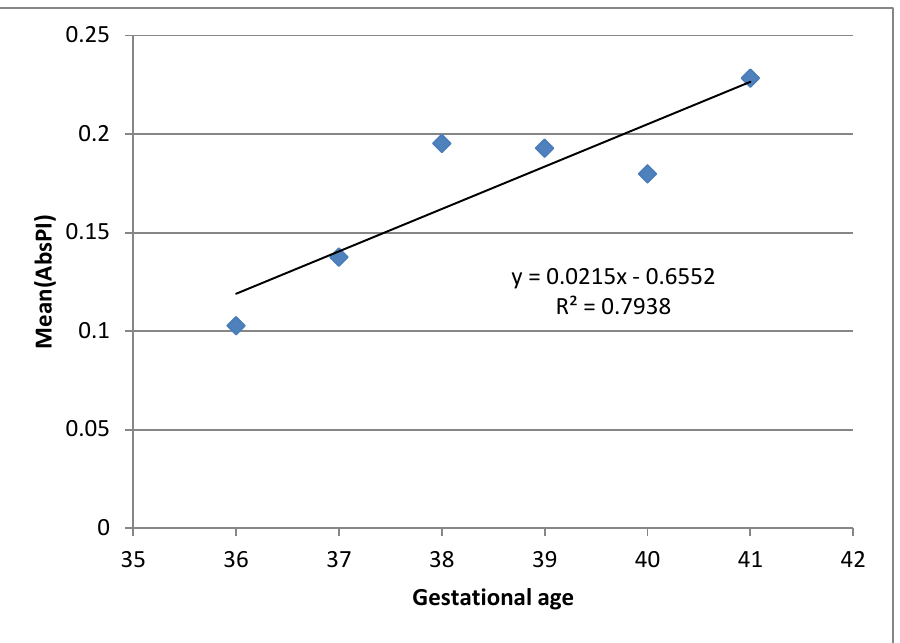
Figure 3. Dependence of mean AbsPI value up to gestational age (GA). AbsPI = absolute PI changes. Mean (AbsPI) represents the mean of all pregnant women AbsPI values in a given gestational week.